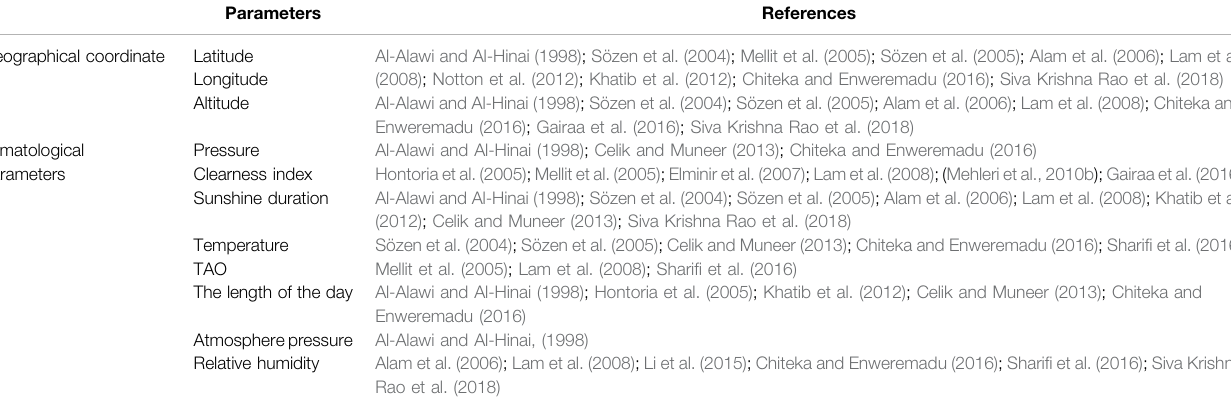
TABLE 1 | Current parameters adopted in the literature to predict and estimate global solar radiation. Parameters